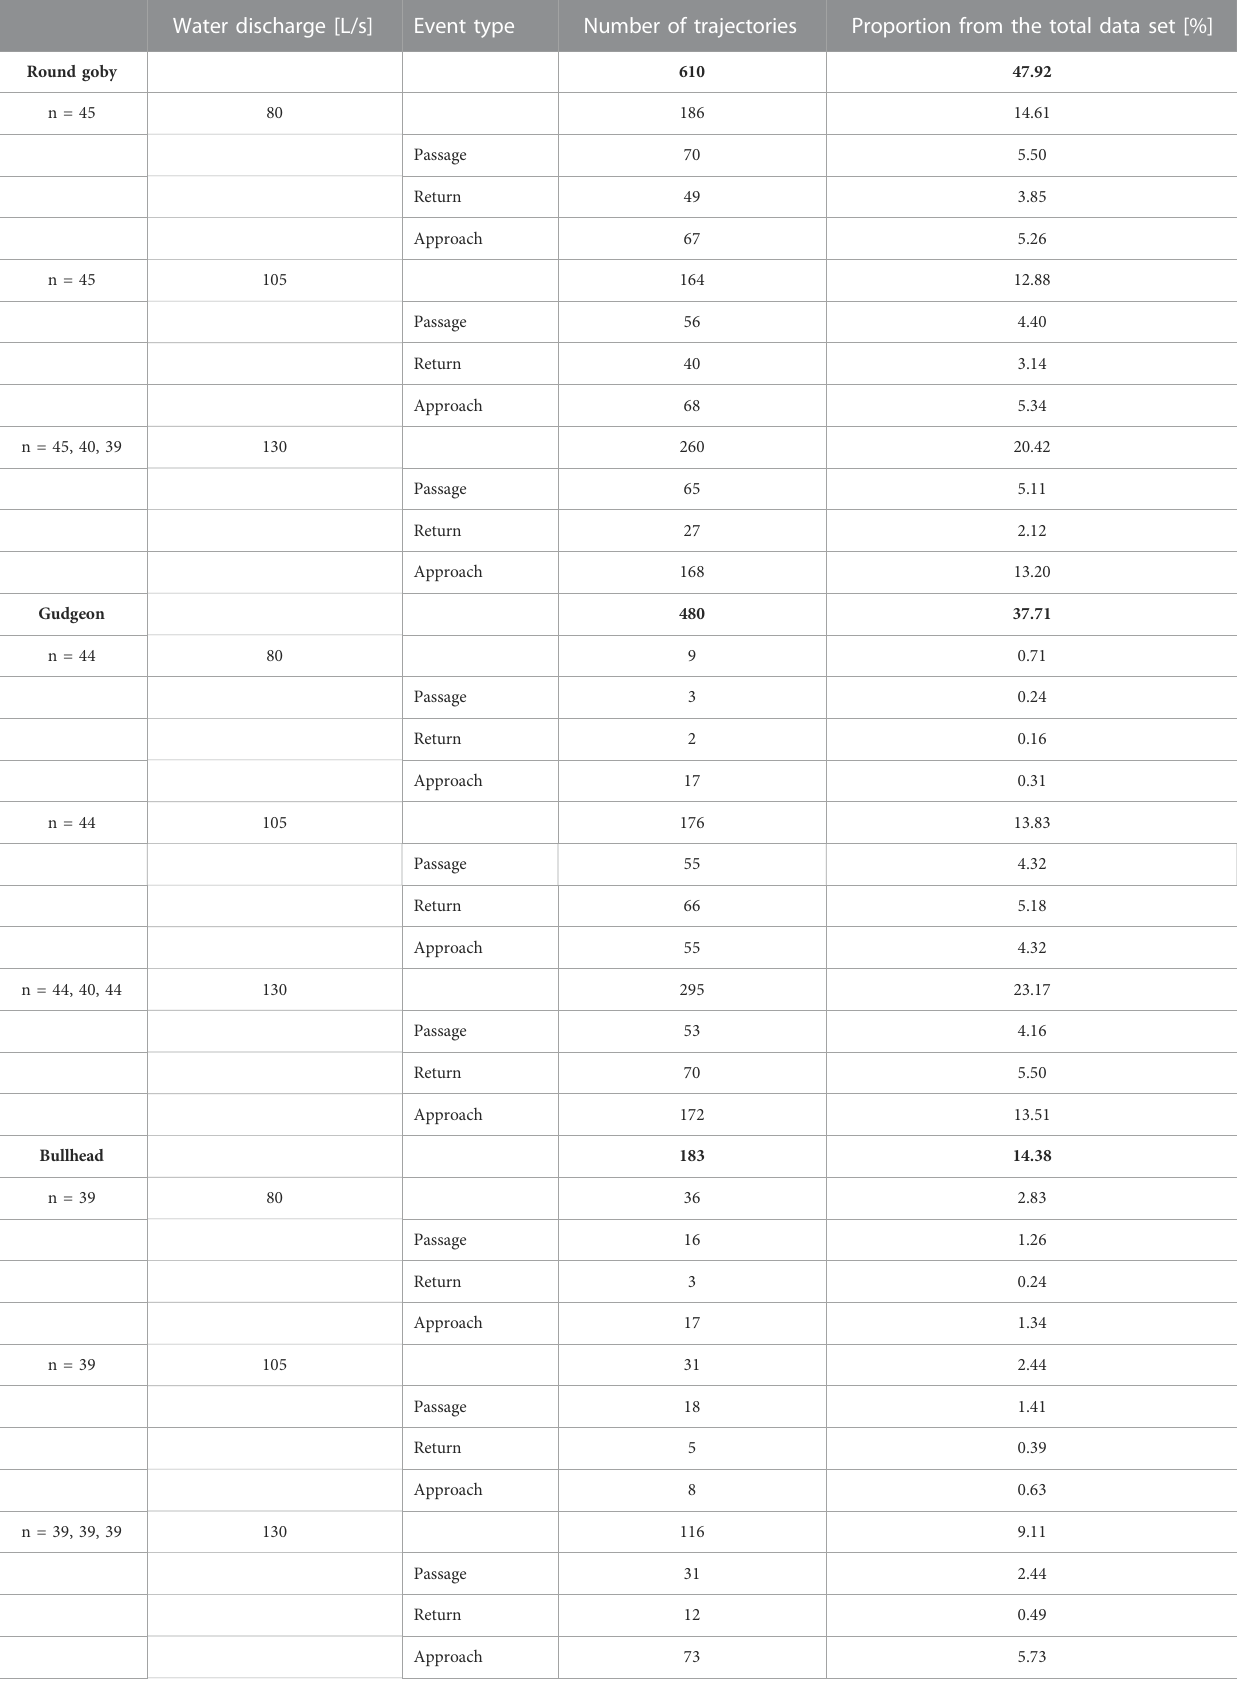
TABLE2Number oftrajectories andtheirproportionfromthe totaldataset(1,273)forthedifferentspecies,water discharges, andeventtypes.Thetotalnumbers and percentages of trajectories per species are highlighted in